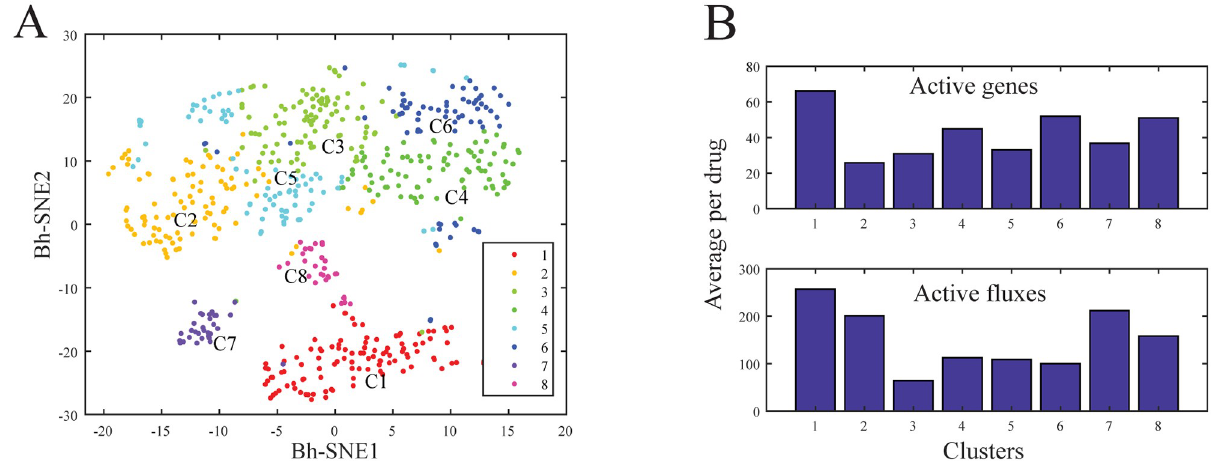
Fig 4. Drug community identification based on measured transcriptional and simulated gut wall metabolic profile. A-Visualization of the eight validated drug clusters through a Bh-SNE plot. B-Transcriptional and gut metabolic activity of the identified clusters showed different levels of drug specificity per